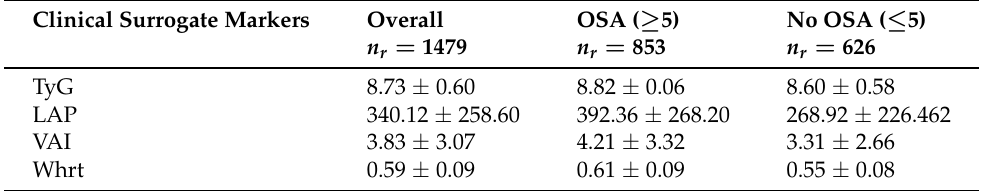
Table A4. Clinical surrogate marker characteristics of cohort expressed as mean ± standard deviation.